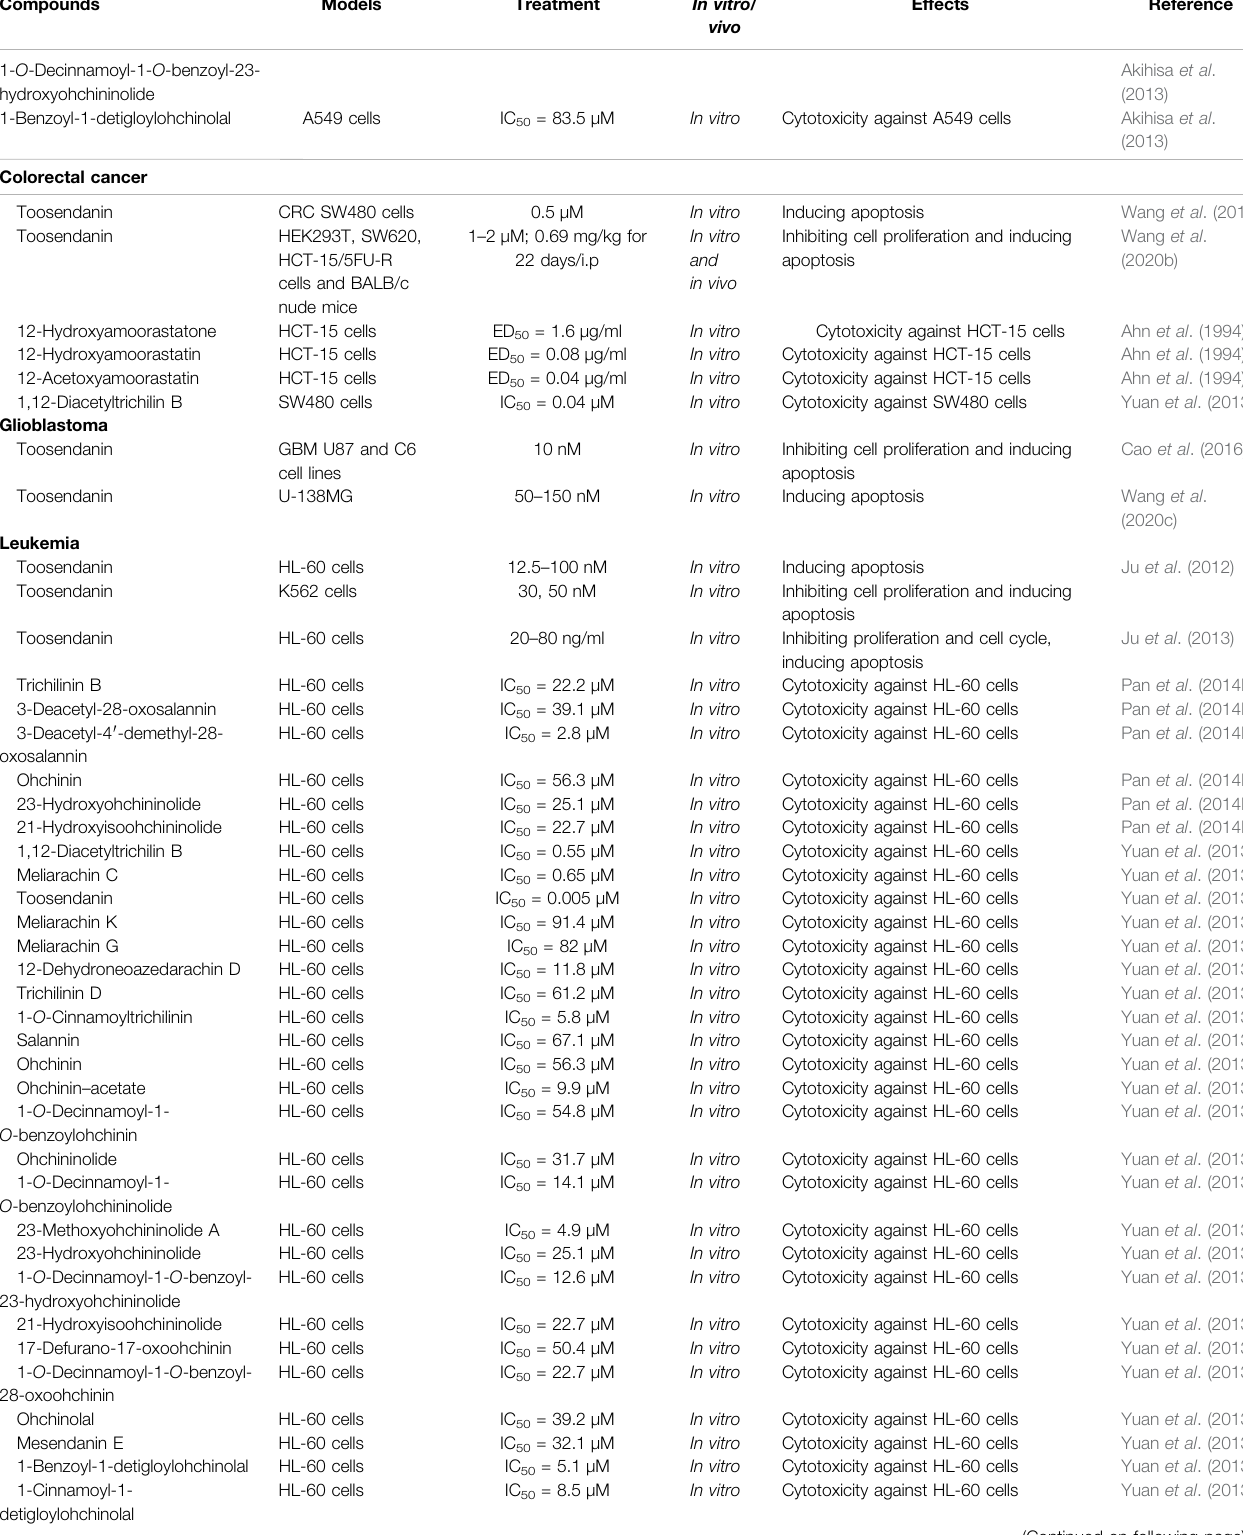
TABLE 2 | ( Continued ) Pharmacological effects of